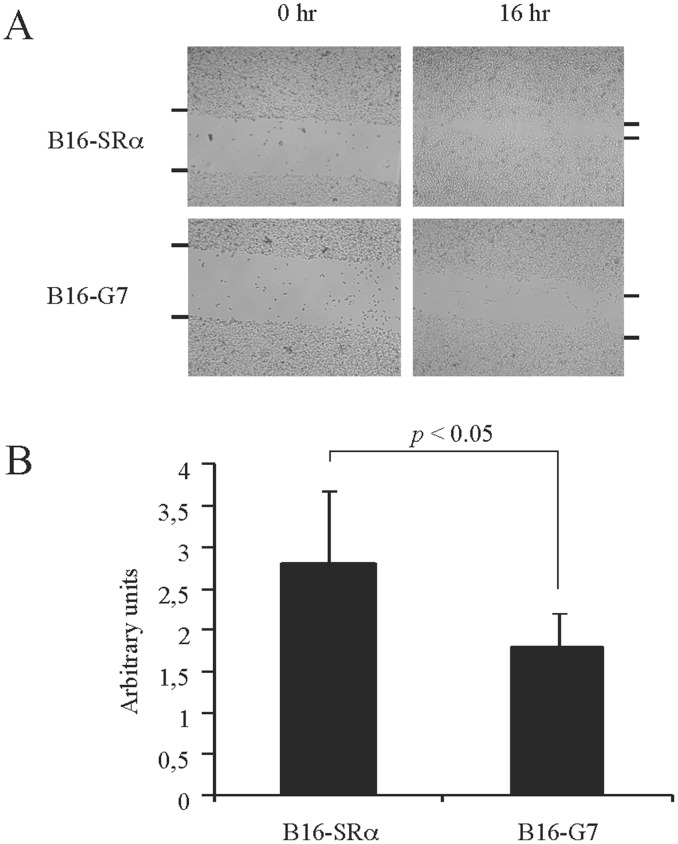
Effect of galectin-7 on B16F1 cell migration.A) Images of the motility assay after the wounding of confluent B16F1 cells overexpressing galectin-7 (B16-G7) or controls (B16-Srα) at T = 0 and T = 16 hr. A mixture of three clones of B16F1-G7 was used (G7 #5, 10 and 14). B) Representative graph of the results obtained in (A).